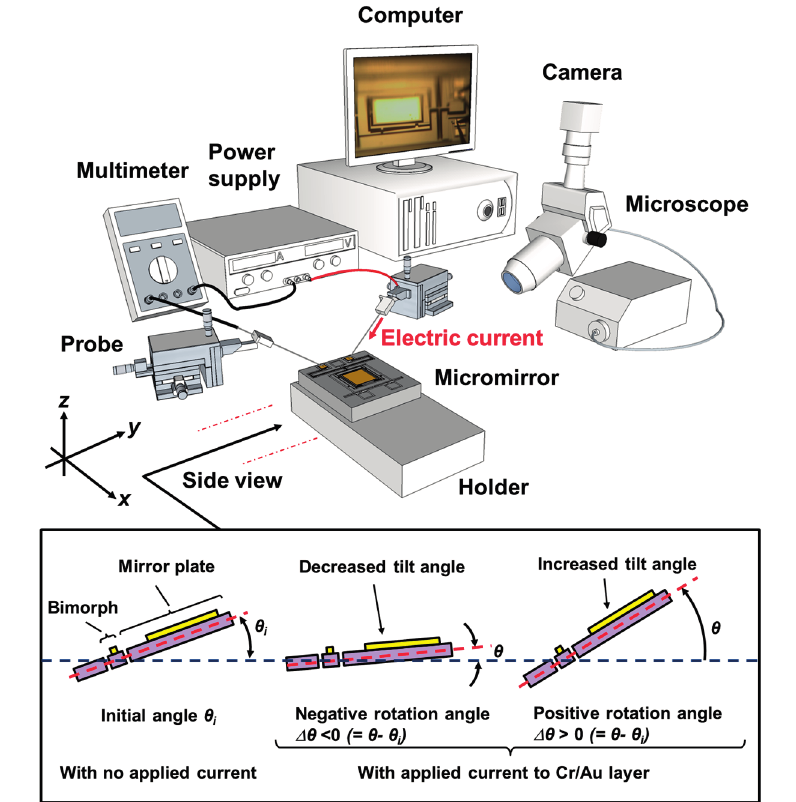
Figure 4. Experimental setup for measuring the rotation angle, corresponding voltage and electrical resistance of the MEMS mirror when an external electric current is